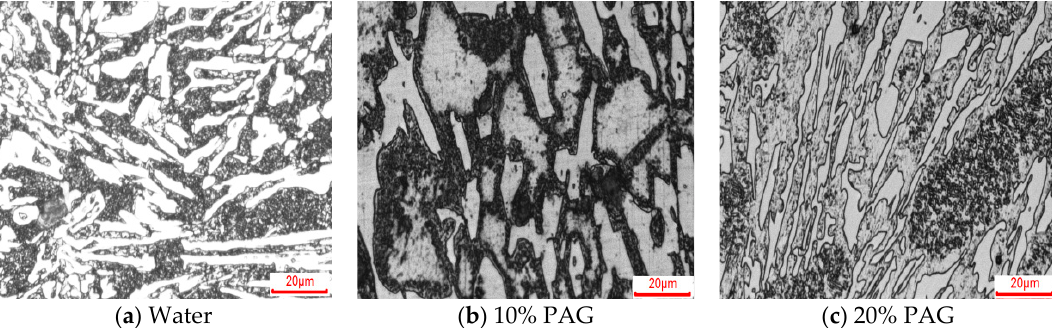
Figure 2. Microstructure of high chromium cast iron with different quenching mediums.